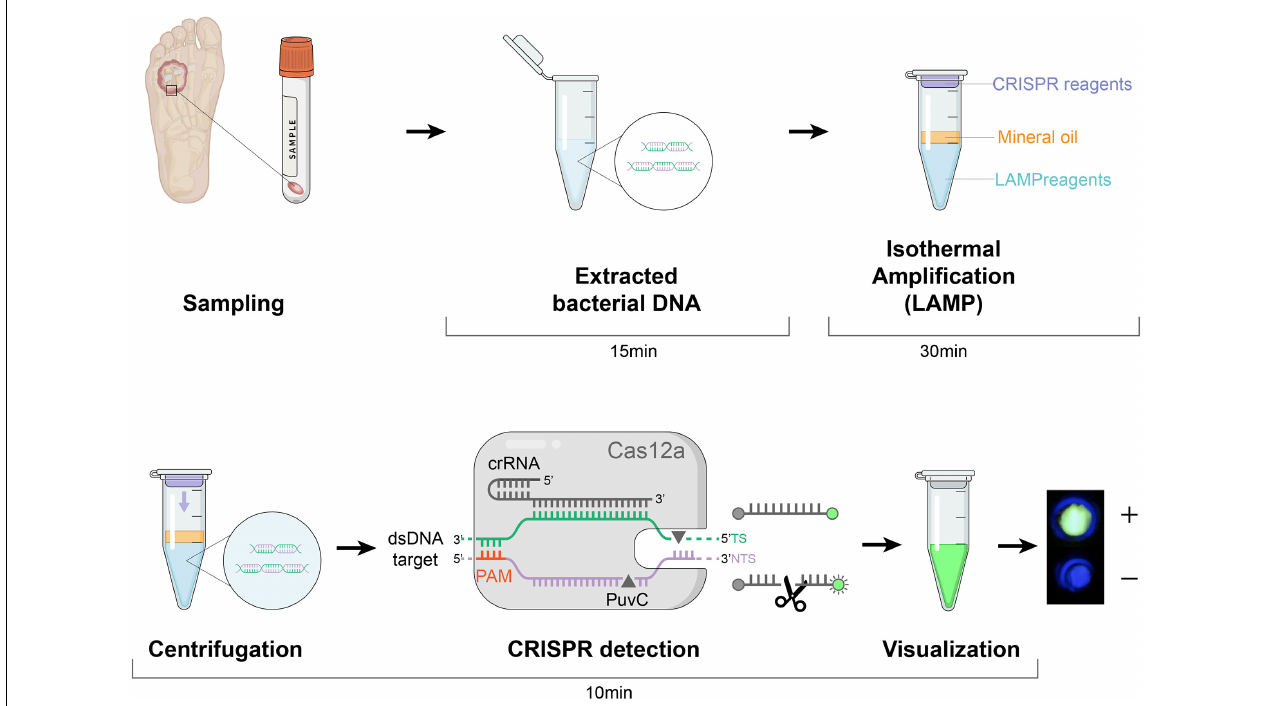
FIGURE 3 | Schematic of the LAMP-CRISPR assay workflow. Quick DNA extraction was used as an input to the LAMP-CRISPR system (LAMP preamplification and Cas12-based detection for nuc and mecA ). The result is visualized by a fluorescence reader.